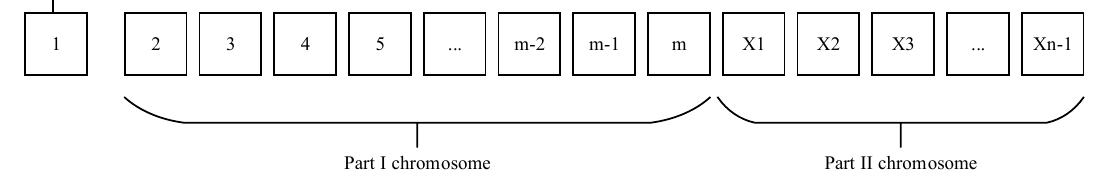
Figure 2. Two-segment chromosome coding format.